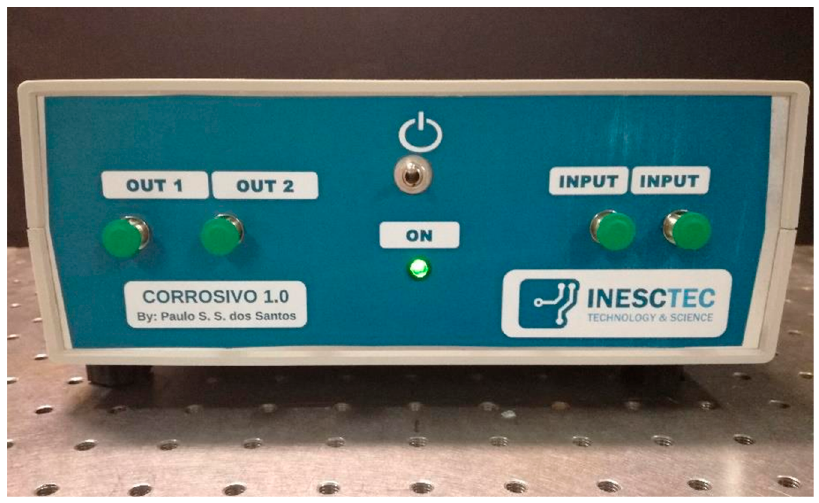
Figure 4. Interrogation unit prototype.